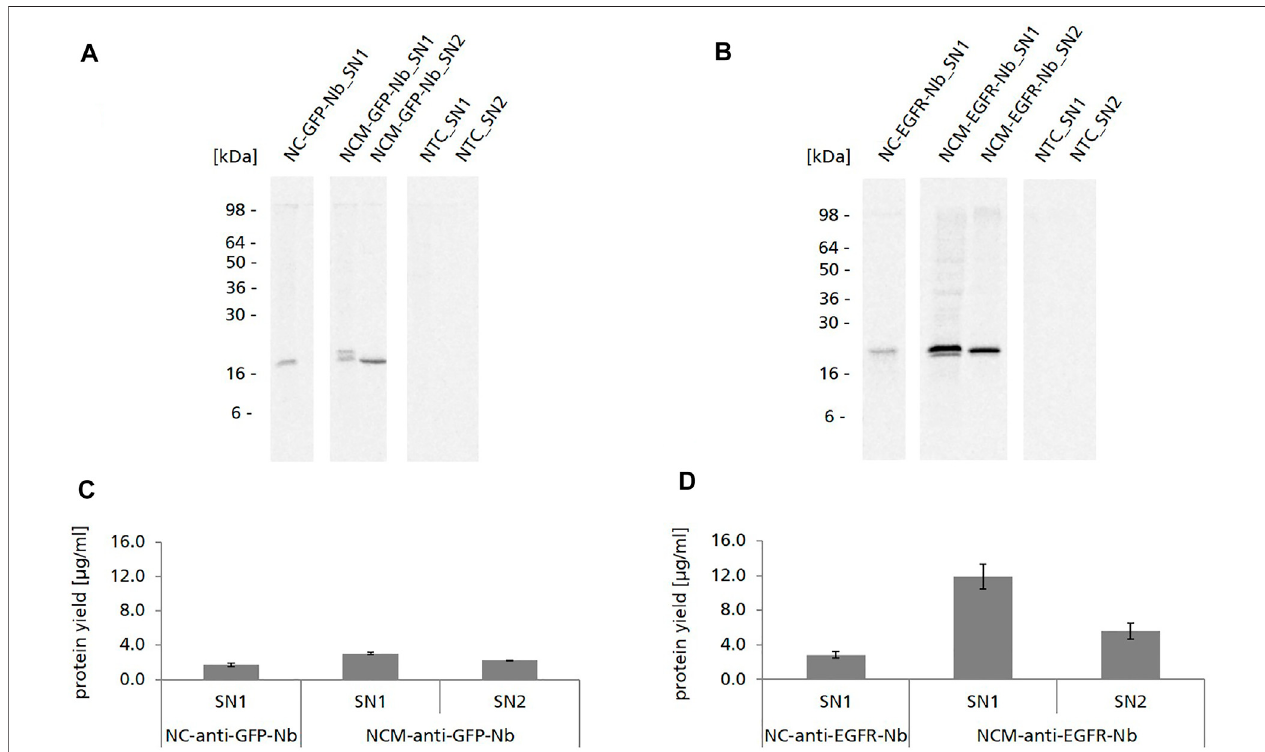
FIGURE 2 | Cell-free synthesis of anti-GFP-Nb and anti-EGFR-Nb based on CHO lysate. (A,B) Autoradiographs showing 14 C-leucine labeled Nanobodies in both soluble fractions of the translation mixture (SN1, SN2). (C,D) . Quantitative analysis of cell-free synthesized Nbs was performed by liquid scintillation counting. Standard deviations were calculated from quadruplicate